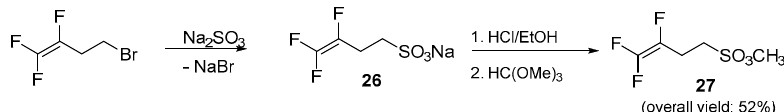
Scheme 5. Synthetic strategy for homoallylic fluorosulfonic ester 27 .